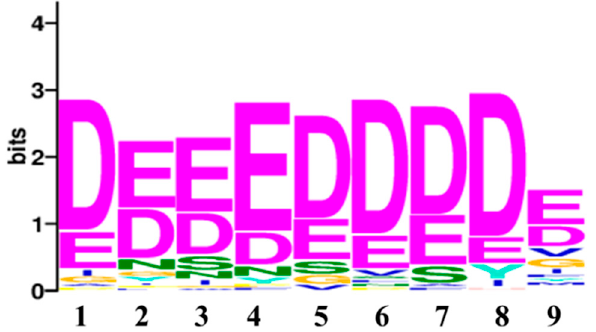
Figure 8. The enriched motif identified in the protein targets of Penetratin, using STREME (Sensitive, Thorough, Rapid, Enriched Motif Elicitation) tool of Multiple Expression motifs for Motif Elicitation (MEME) suite. The identified motif was significantly enriched with a p -value of 0.03 and was observed in 57 protein targets of penetratin.